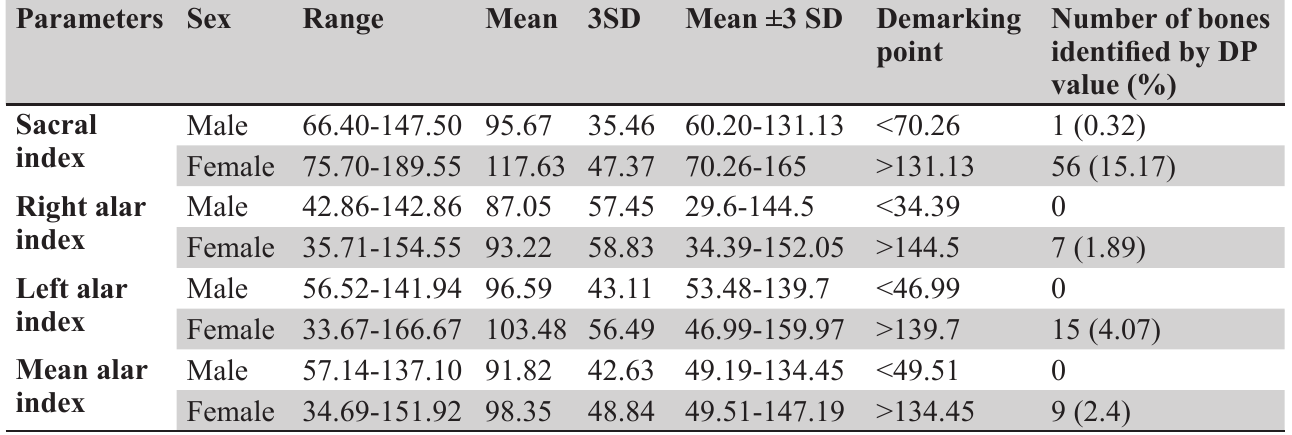
Table 2: Calculation of demarking points of sacral and alar indices. Parameters